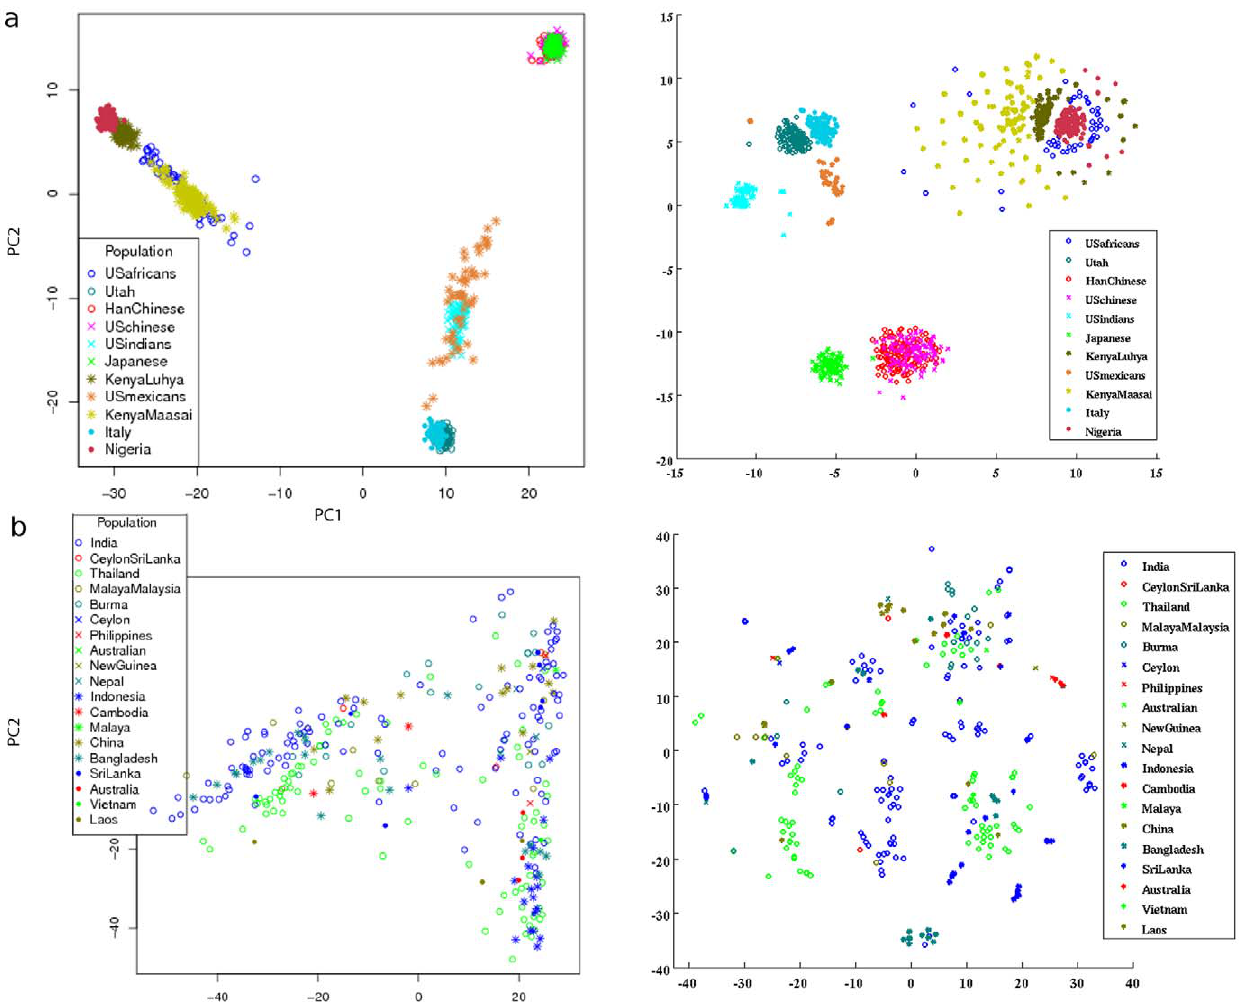
Figure 2. SNP data transformed with PCA and t-SNE 2/2. On the left is a PCA-plot with the first two components, on the right a t-SNE-plot of the very same data from each data source. Data sources: Panel (a) from hapmap3 r3 (compare with Fig. 1c) and (b) from the Rice Haplotype Map Project (only wild type where the label information was available).